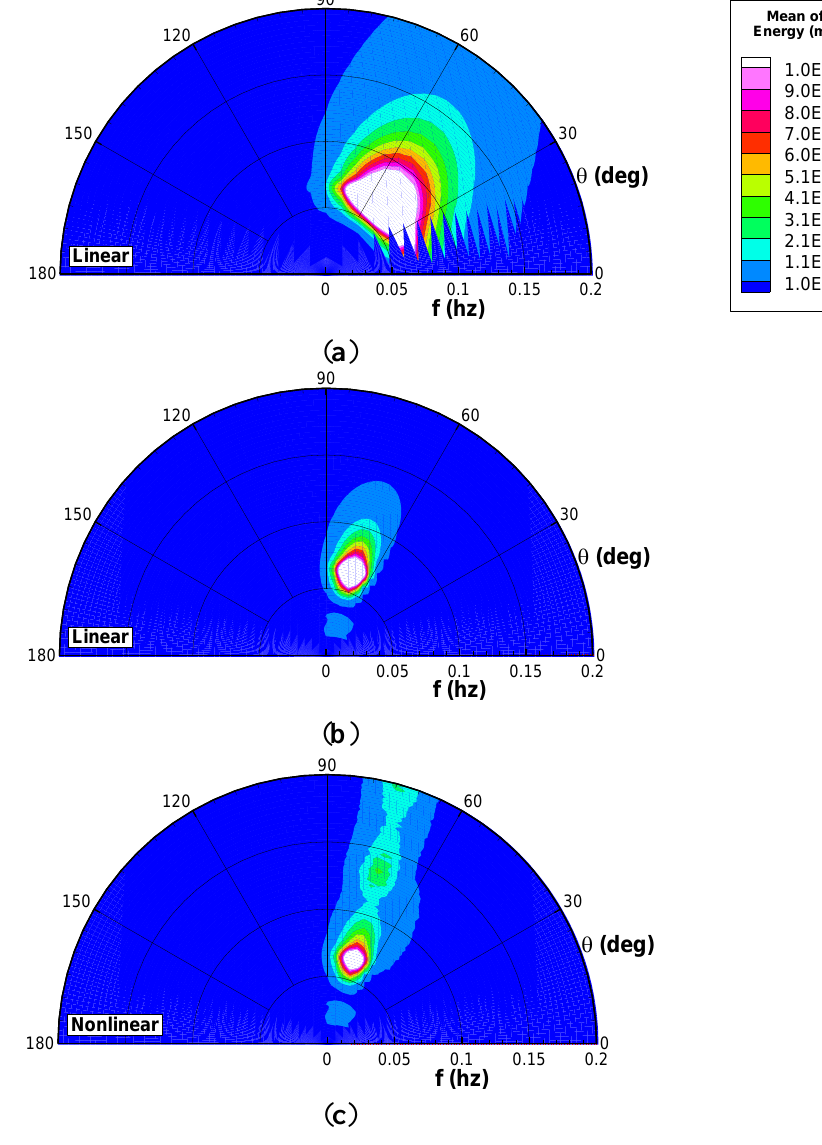
Figure 7. Evolution of the directional oblique JONSWAP spectrum (see Table 1). ( a ) Initial spectrum in 15 m water depth; ( b ) Linear evolution (3 m water depth); ( c ) Nonlinear evolution (3 m water depth). Simulations are averages over N = 100 random phase